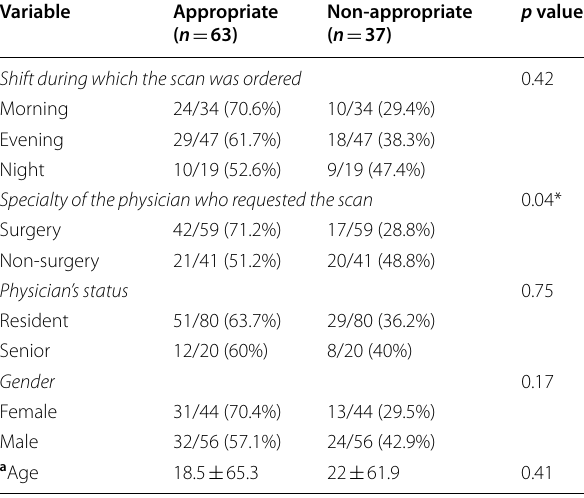
Table 4 Analysis of CT orders regarding Experts’ Assessment of Appropriateness (prior to ESR): Pearson chi-square test